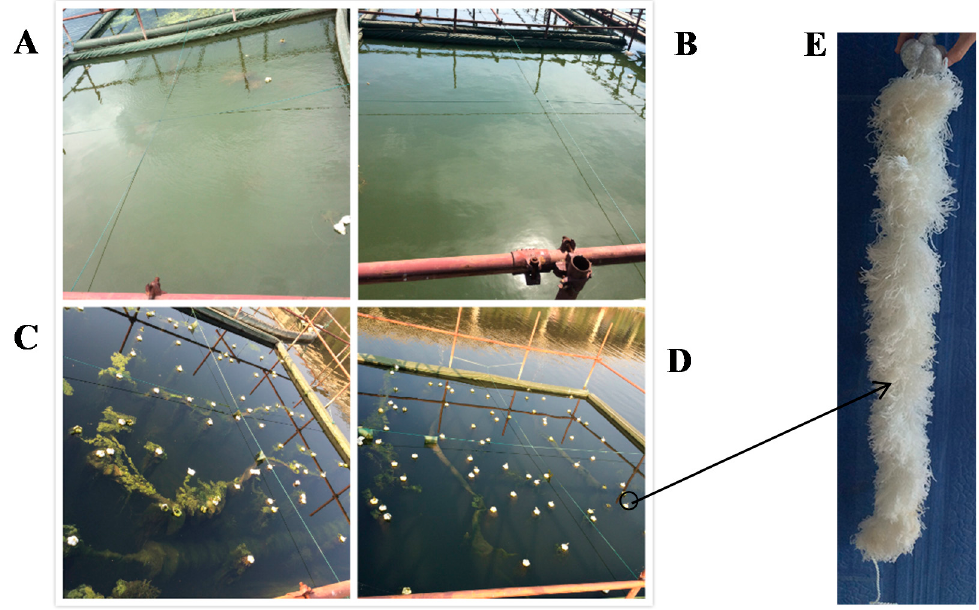
Figure 2. Experimental setup of the enclosures and structure of the ( E ) artificial aquatic plant (AAP); ( A , B ) control enclosures; ( C , D ) treated enclosures with 1 strand AAP / m 3 with length of 80–85 cm.